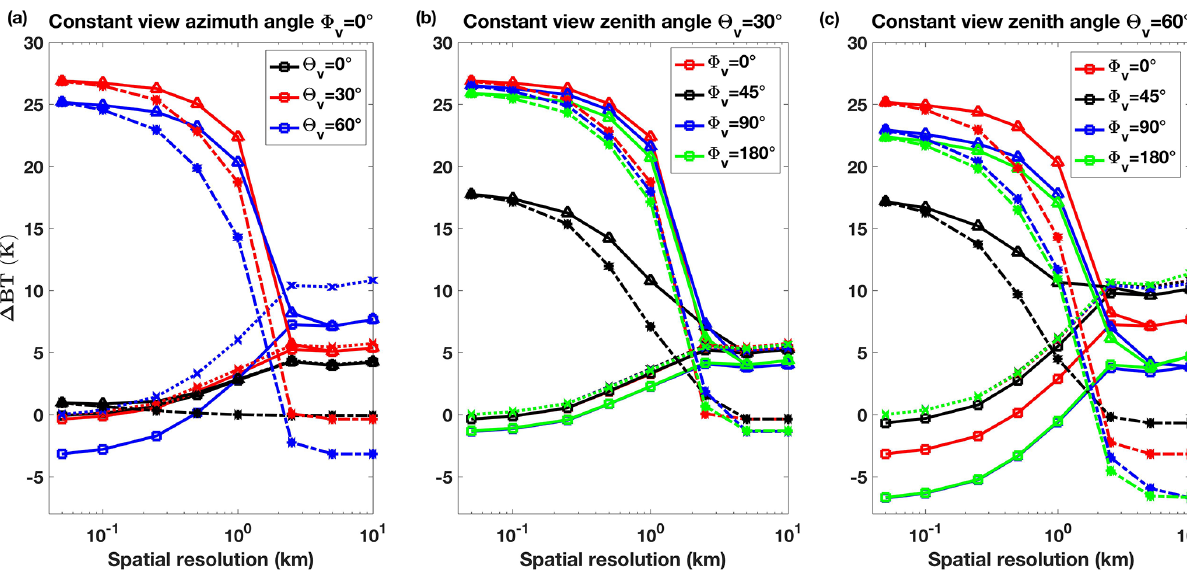
Figure 13. Mean absolute difference (MAD, lines with triangles) and average mean difference (AMD, lines with squares) between 3-D and 1-D brightness temperatures estimated following Eq. (2), plane-parallel and homogenous bias (PPHB, doted lines with crosses) and independent pixel approximation error (IPAE, dashed lines with stars) as a function of the spatial resolution for the channel centered at 11 . 01µm and as a function of (a) the viewing zenith angle (cid:50) v at an azimuth angle of (cid:56) v = 0 ◦ , (b) the viewing azimuth angle at (cid:50) v = 30 ◦ and (c) the viewing azimuth angle at (cid:50) v = 60 ◦